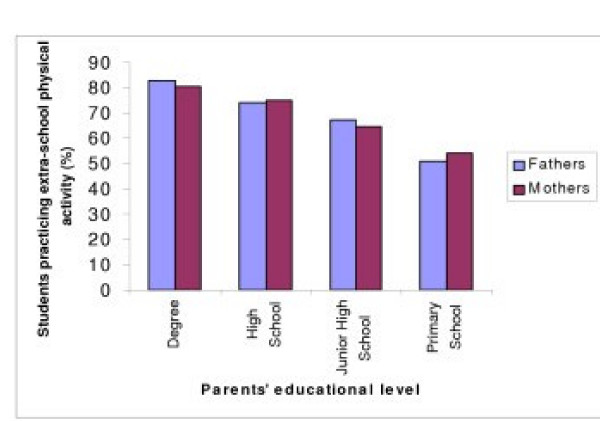
Relation between students' extra-school physical activity and parents' educational level.